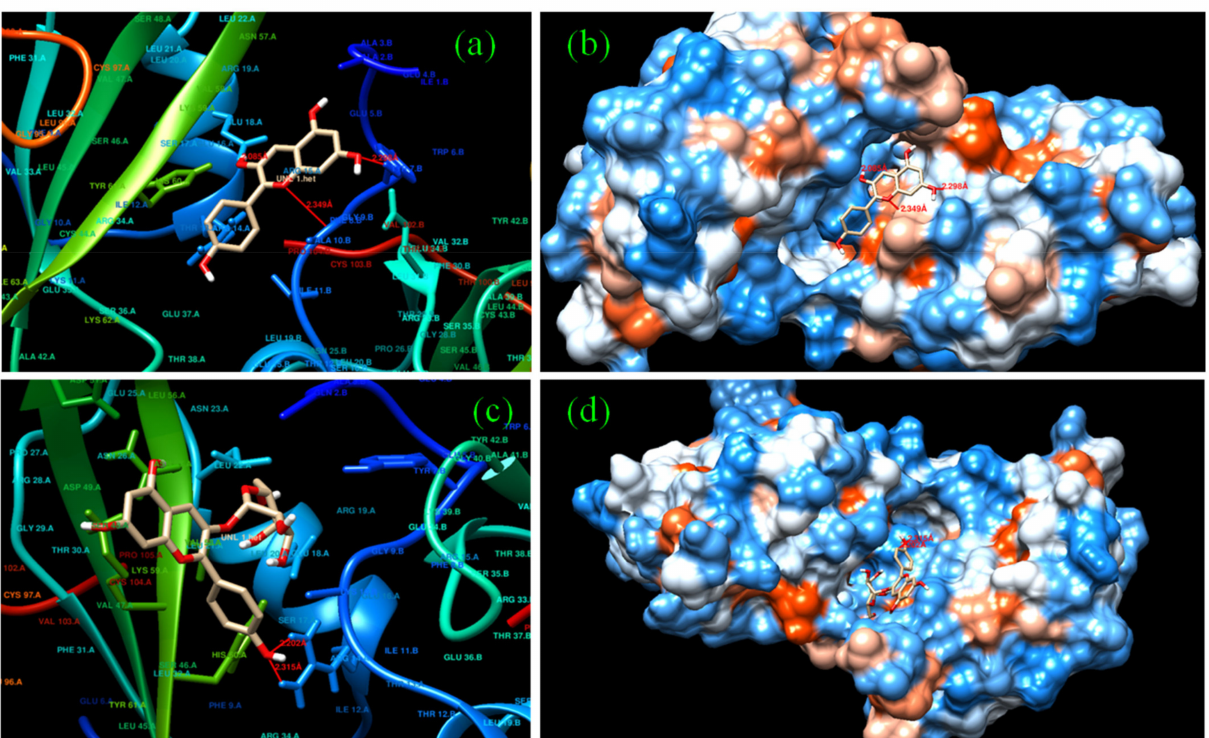
Figure 5. Docked poses of ( a , b ) pelargonidin and ( c , d ) pelargonidin-3-O-glucoside with